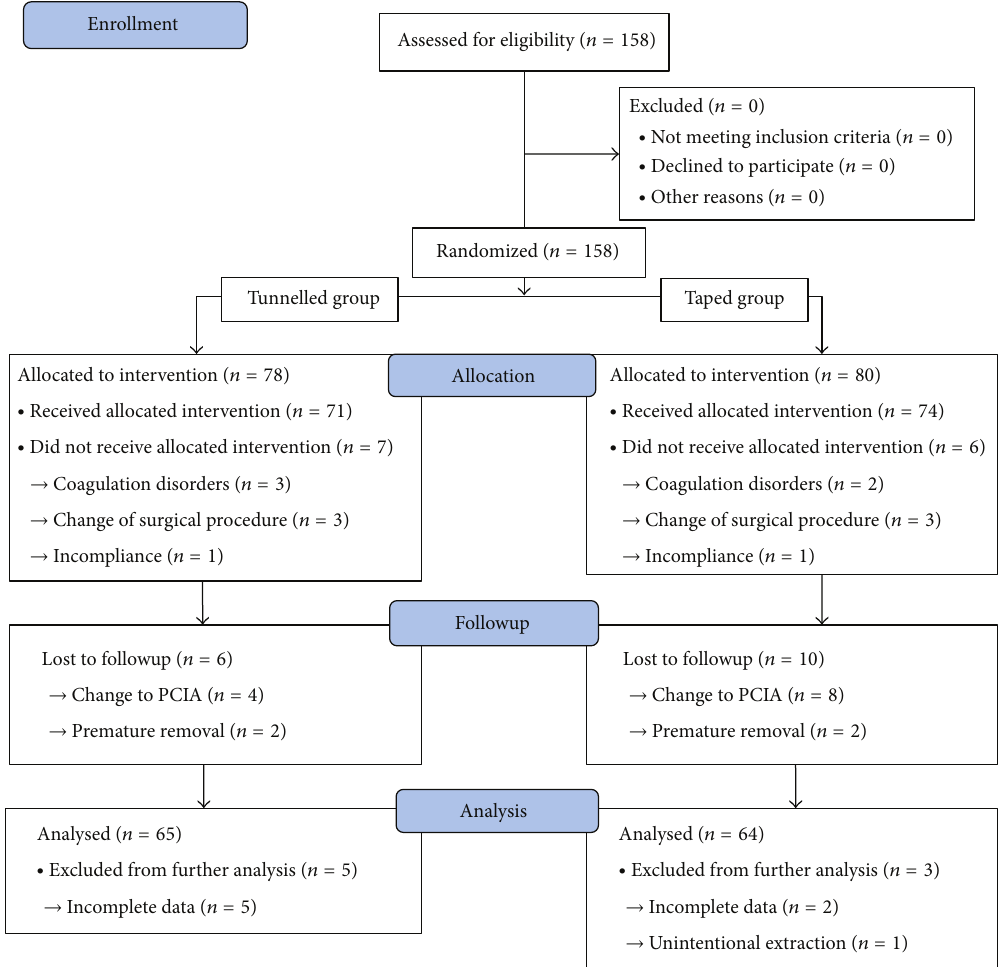
Figure 1: Flow chart according to CONSORT guidelines. PCIA patient controlled intravenous